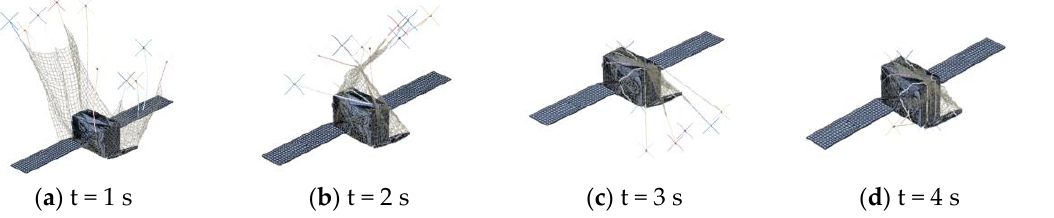
Figure 1. Capture process of rectangular tether-net, ( a ) t = 1 s, ( b ) t = 2 s, ( c ) t = 3 s, ( d ) t = 4 s.